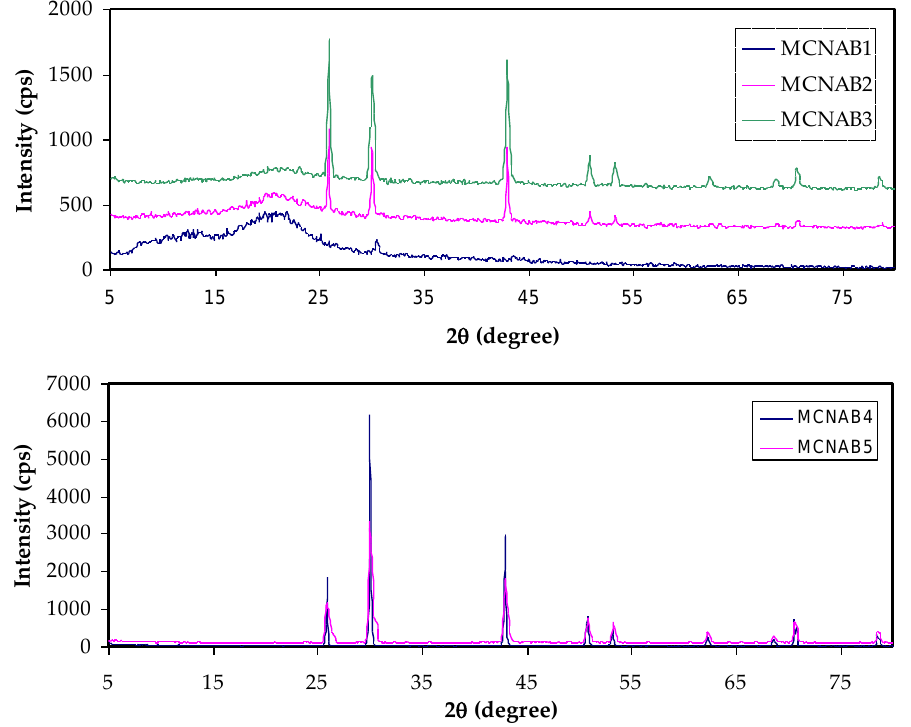
Figure 2. XRD pattern of ( a ) neat MC film and ( b ) NaBr salt.